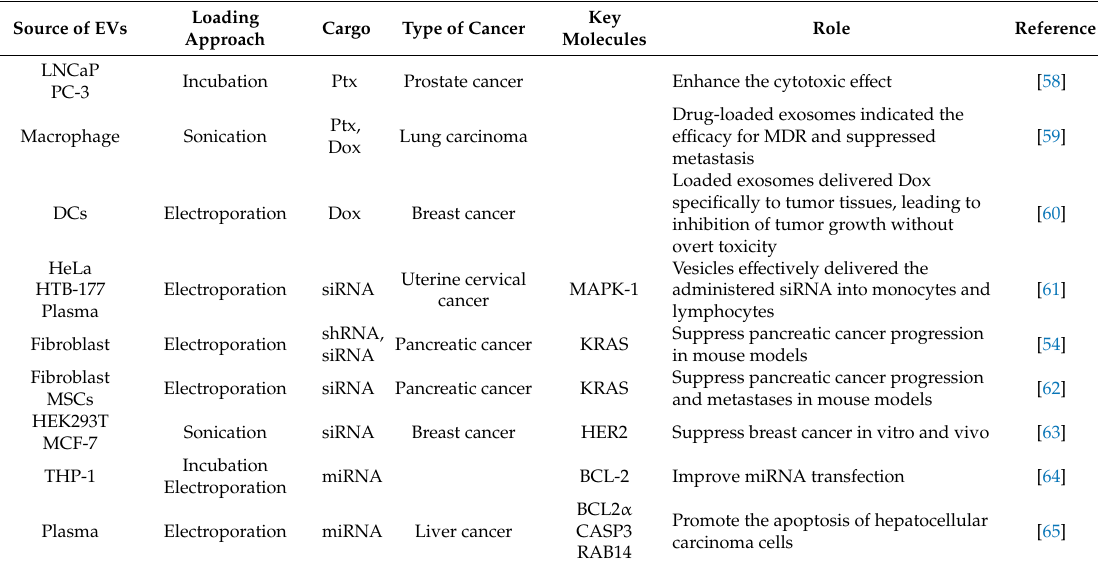
Table 2. Summary of the potential molecules, loading approaches and roles in exosome-based therapies. Source of